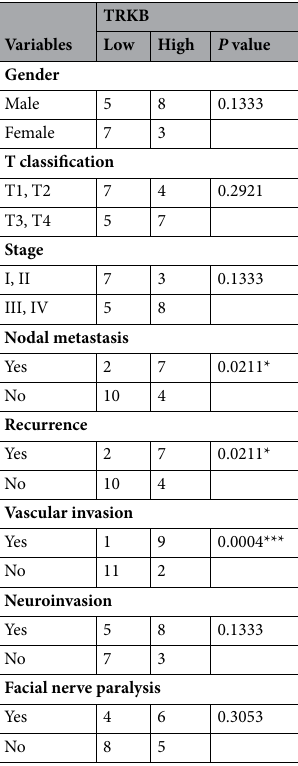
Table 1. Correlation between TRKB expression levels and clinicopathological characteristics of patients with PGC (n = 23). Statistical analyses were performed using Pearson’s χ 2 test or Fisher’s exact test. * P < 0.05; *** P <